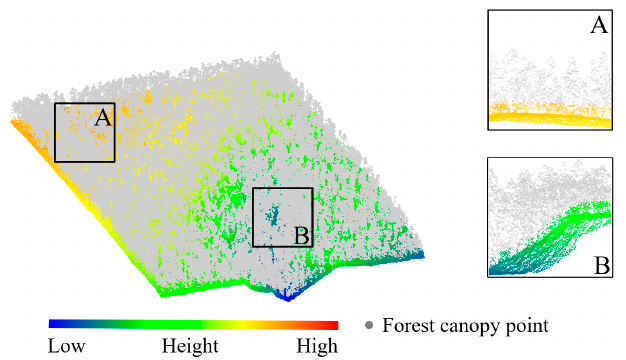
Figure 6. The results of point extraction under forest canopy in a sample site (Site 2). The proposed method can effectively extract the points under forest canopy in gentle slopes and steep slopes, as shown in the enlarged figures A and B.